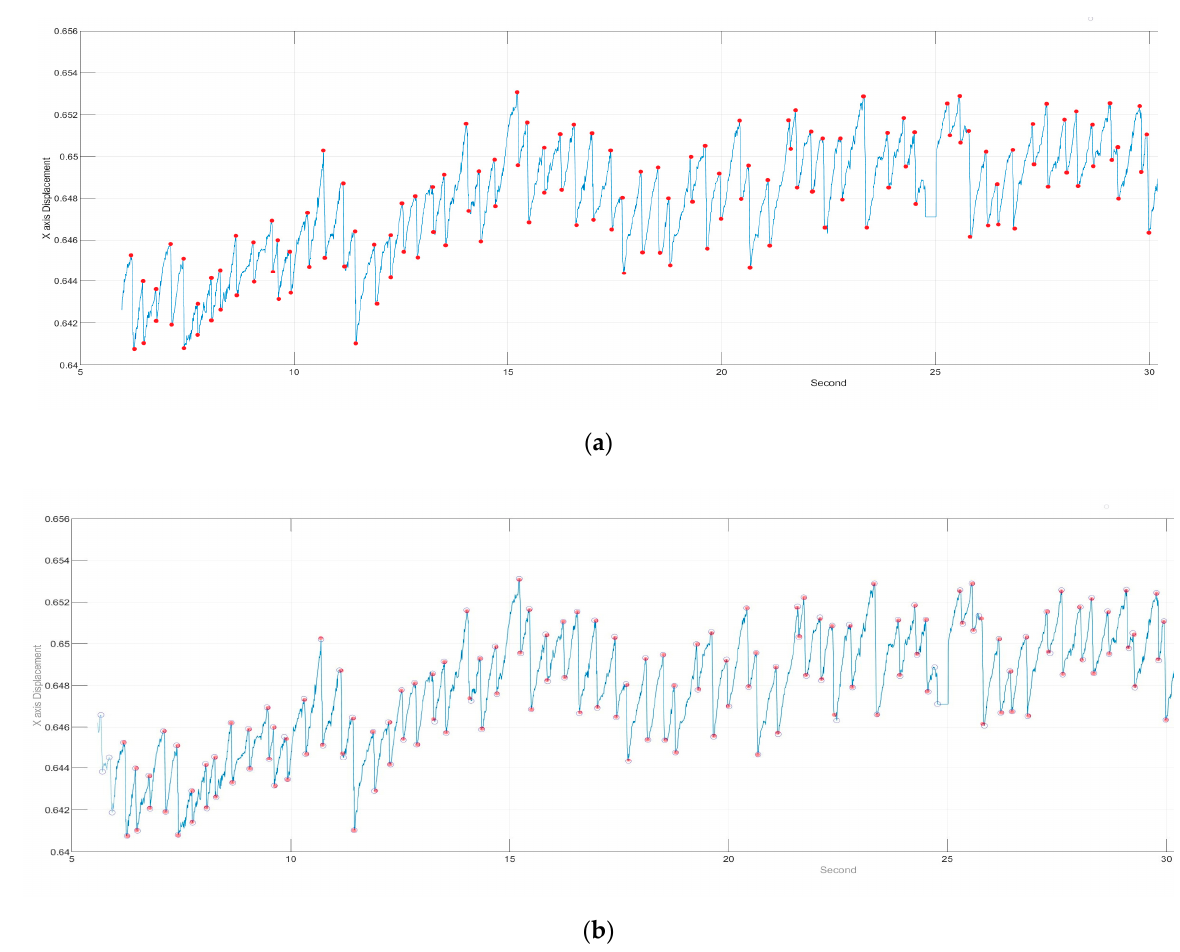
Figure 6. Results of the proposed method: ( a ) Results marked by the physician; ( b ) the comparison of the results of this method and those marked by the physician. Table 4. Average Accuracy of Each Step for Six Subjects.